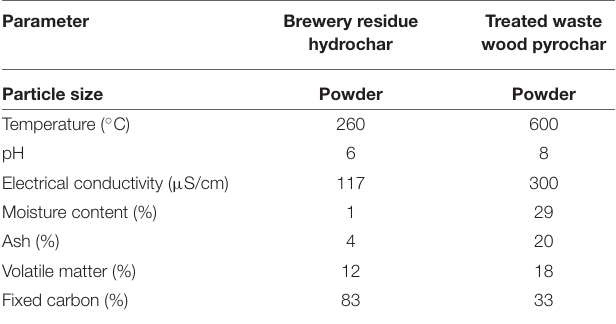
TABLE 3 | Characteristics of biochar used for the AD